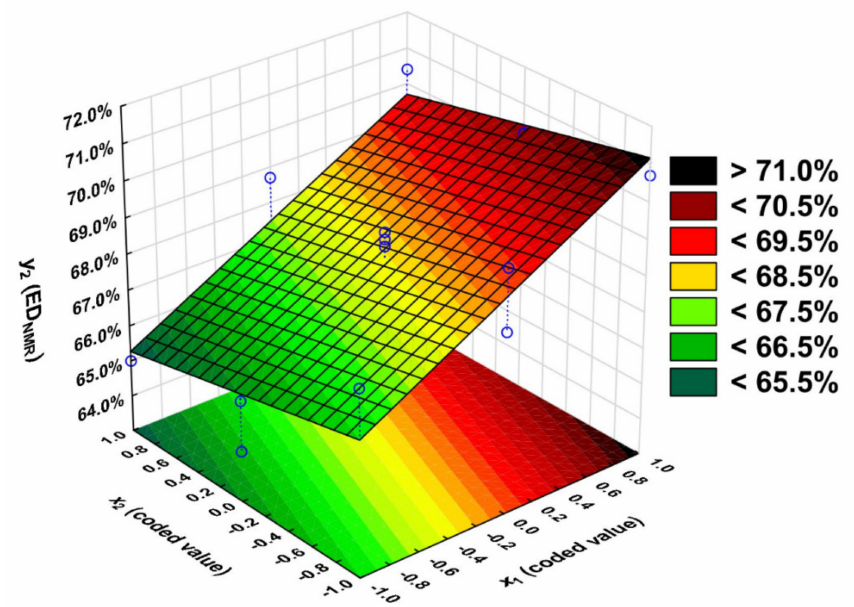
Figure 11. Dependence of esterification degree (ED NMR ) of PGItc, on the OH/COOH ratio ( x 1 ) and the temperature ( x 2 ), x 3 =